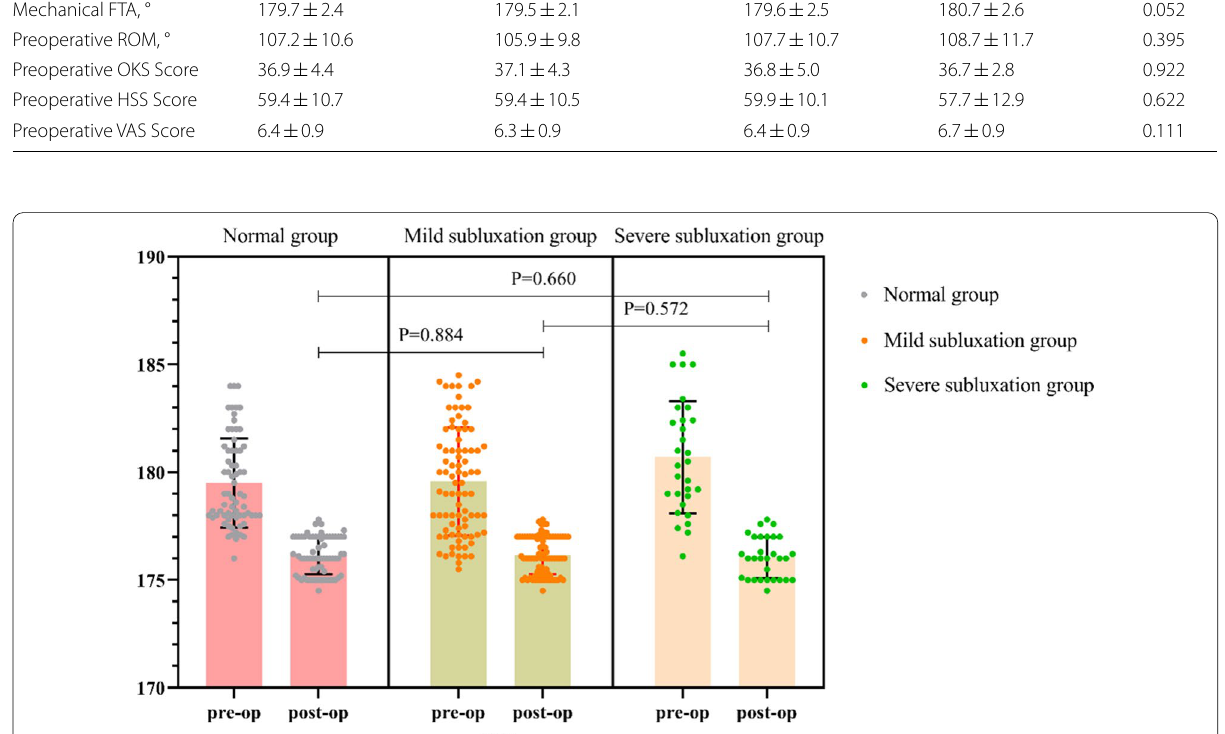
Fig. 2 A Preoperative anterior and posterior X‑ray images of the knee exhibited “bone on bone” contact in the medial compartment, with a measured CTFS of 0.62 cm; B Anterior and posterior X‑ray images of the knee after OUKA revealed satisfactory prosthesis positioning, with a measured CTFS of 0